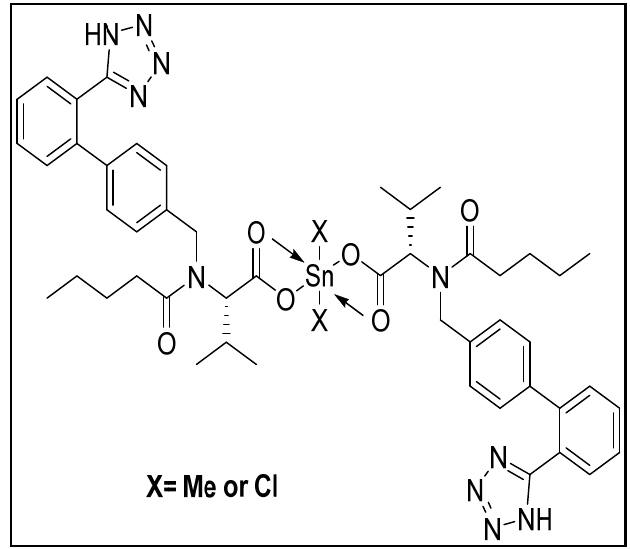
Figure 1. Structure of Me 2 SnL 2 and SnL 2 Cl 2 Complexes.